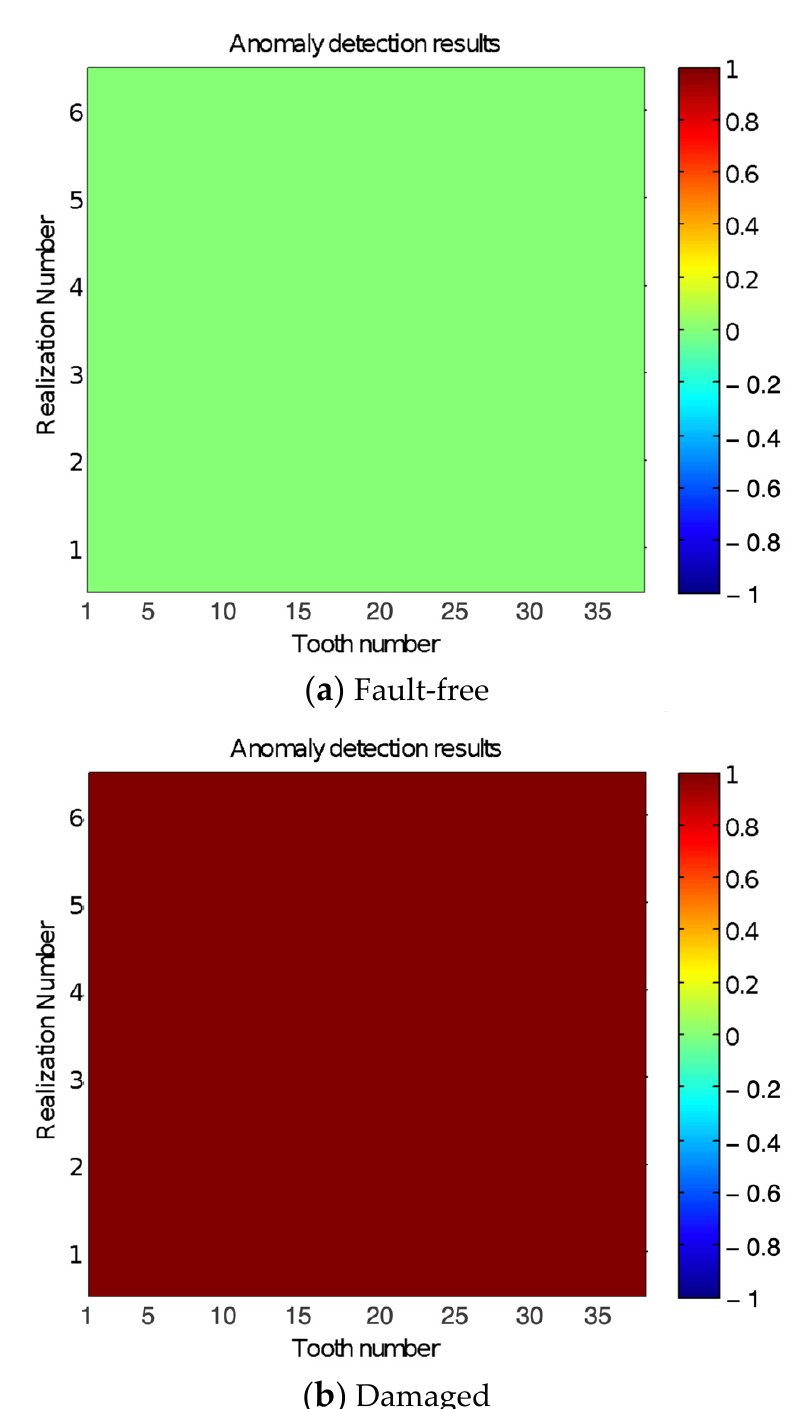
Figure 14. The anomaly detection decision maps, obtained using k-means and k-NN approaches for gear signal.